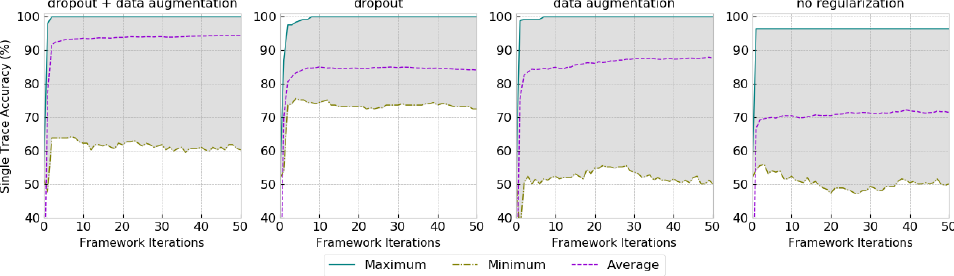
Figure 16: Random CNN hyperparameters: minimum, maximum, and average single trace accuracy with iterative framework on cswap-pointer dataset and attacking the sample interval range from 550 to 800 of all